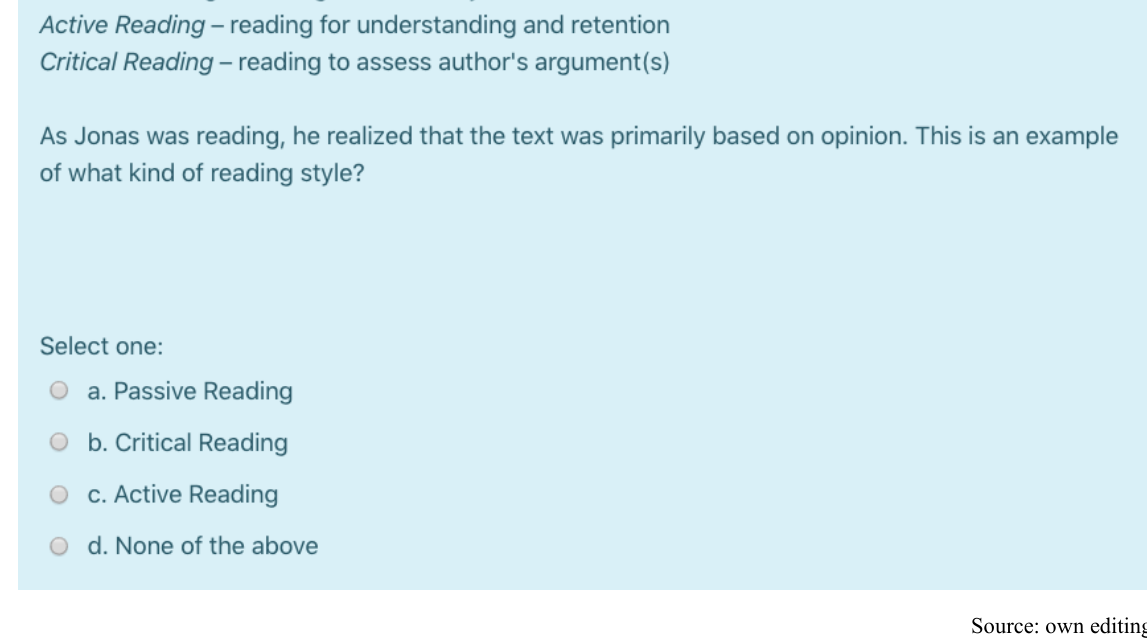
FIGURE 3. SAMPLE TEST